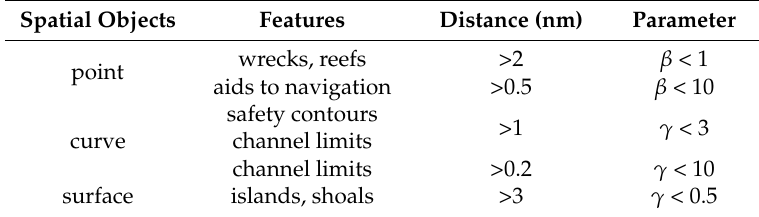
Table 3. Suggested configuration of the parameters β and γ for different spatial